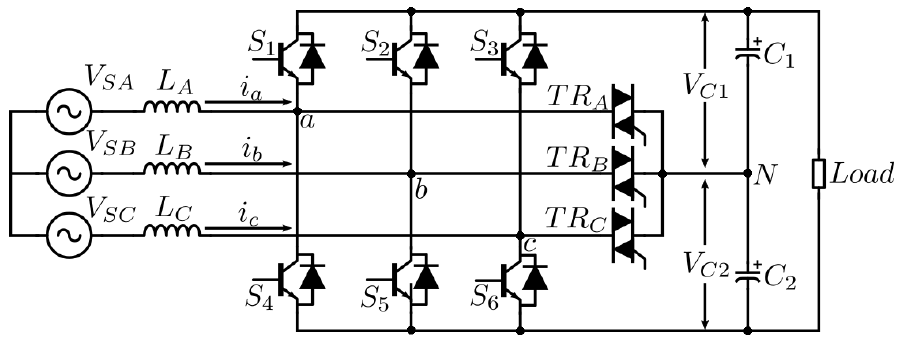
Figure 3. Fault-isolation scheme strategy at the switch level.The TRIAC ( TR A , TR B , TR C ) of the faulty switch ( S 1 ,..., S 6 ) is gated to connect the phase to the midpoint of the DC